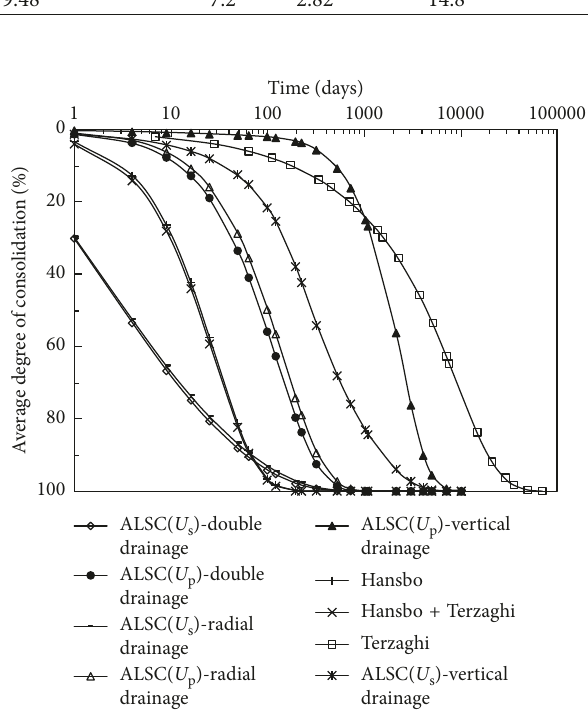
Figure 5: The average consolidation degree versus time for large- strain and small-strain consolidation